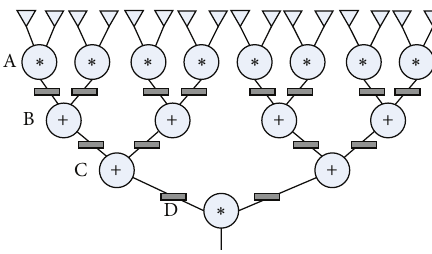
Figure 2: RTL structure of (1) with 16 input ports and maximum resource usage.